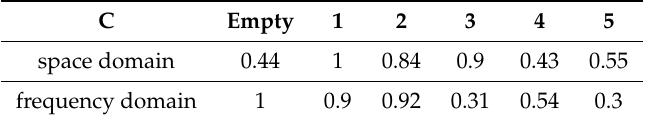
Table 1. Accuracy of subjects counting using maximum likelihood estimation based on normal